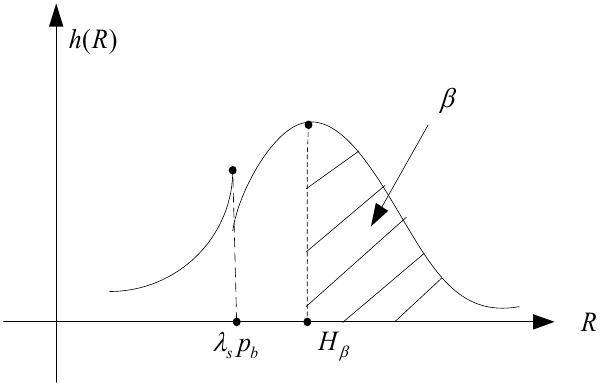
Figure 1. A schematic diagram of the PDF of R